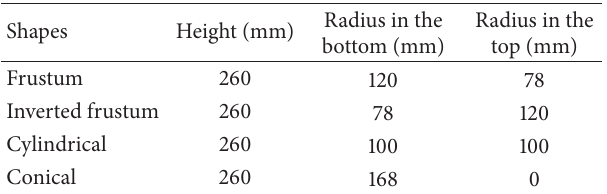
Table 2: Design parameters of the receiver based on equal area- radius